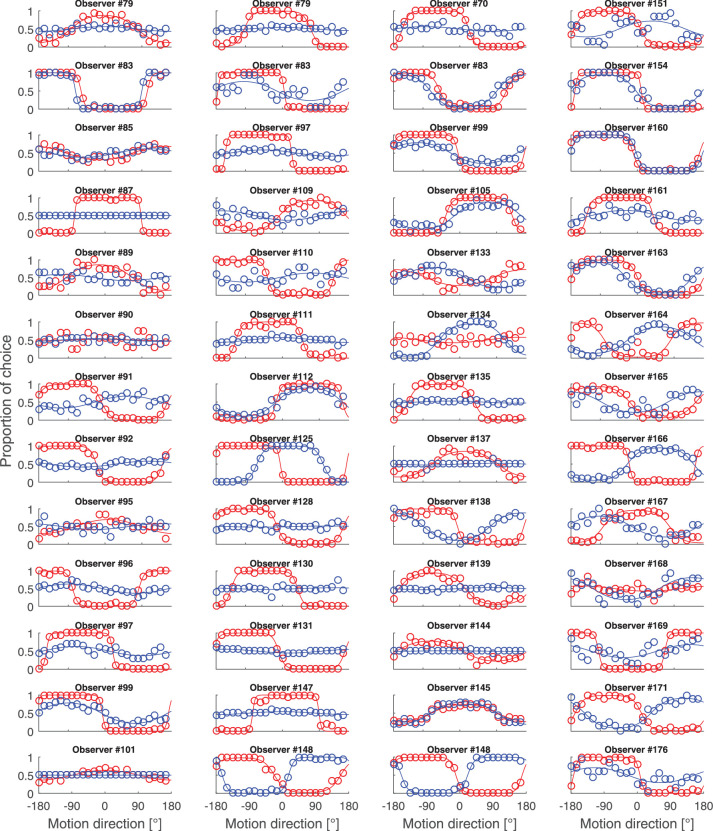
Individual participants' data. Proportion of seen in front as a function of motion direction in transparent motion condition (Red). Proportion of seen dominant as a function of motion direction in binocular rivalry condition (Blue). Each dot indicates the proportion of choice from behavioral data. Solid line indicates fitted model. Each column refers to Experiments 1 to 4. Please note that rows do not represent single observers because different observers participated in the experiments.